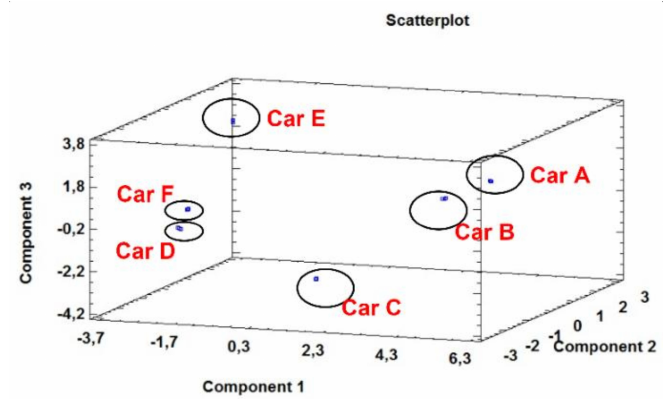
Figure 4. Three dimensional principal components scatterplot of the tested variables at di ff erent maturation stages of cardoon heads (samples Car A–F).